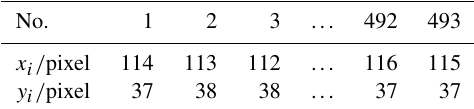
Figure 7. Contour image processing. Table 1. Pixel